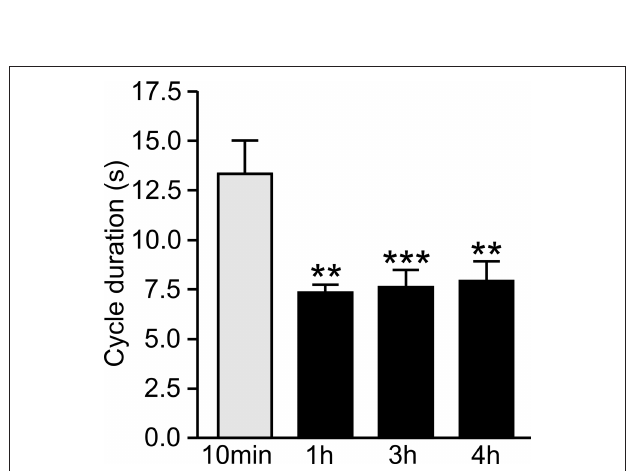
significant inverse correlation ( r = − 0.7, P < 0.05, n = 10) at the 4-h time point. (B) The number of background fictive feeding cycles observed in the 2-min preceding the CS test is not correlated with the N3t frequency ( r = − 0.1, P > 0.05, n = 10).